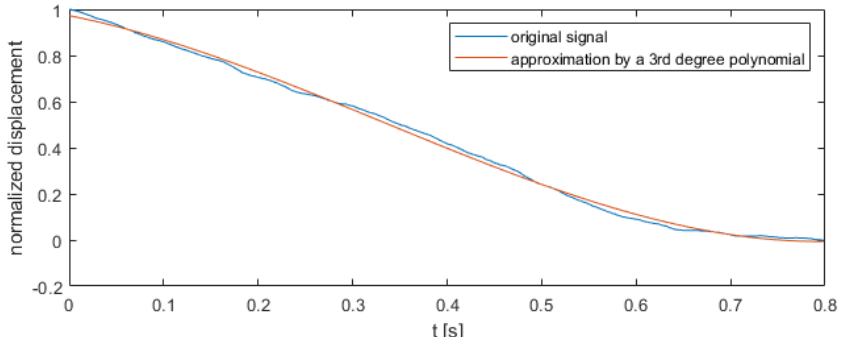
Figure 5. Original signal of displacement and approximation by 3rd degree polynomial.